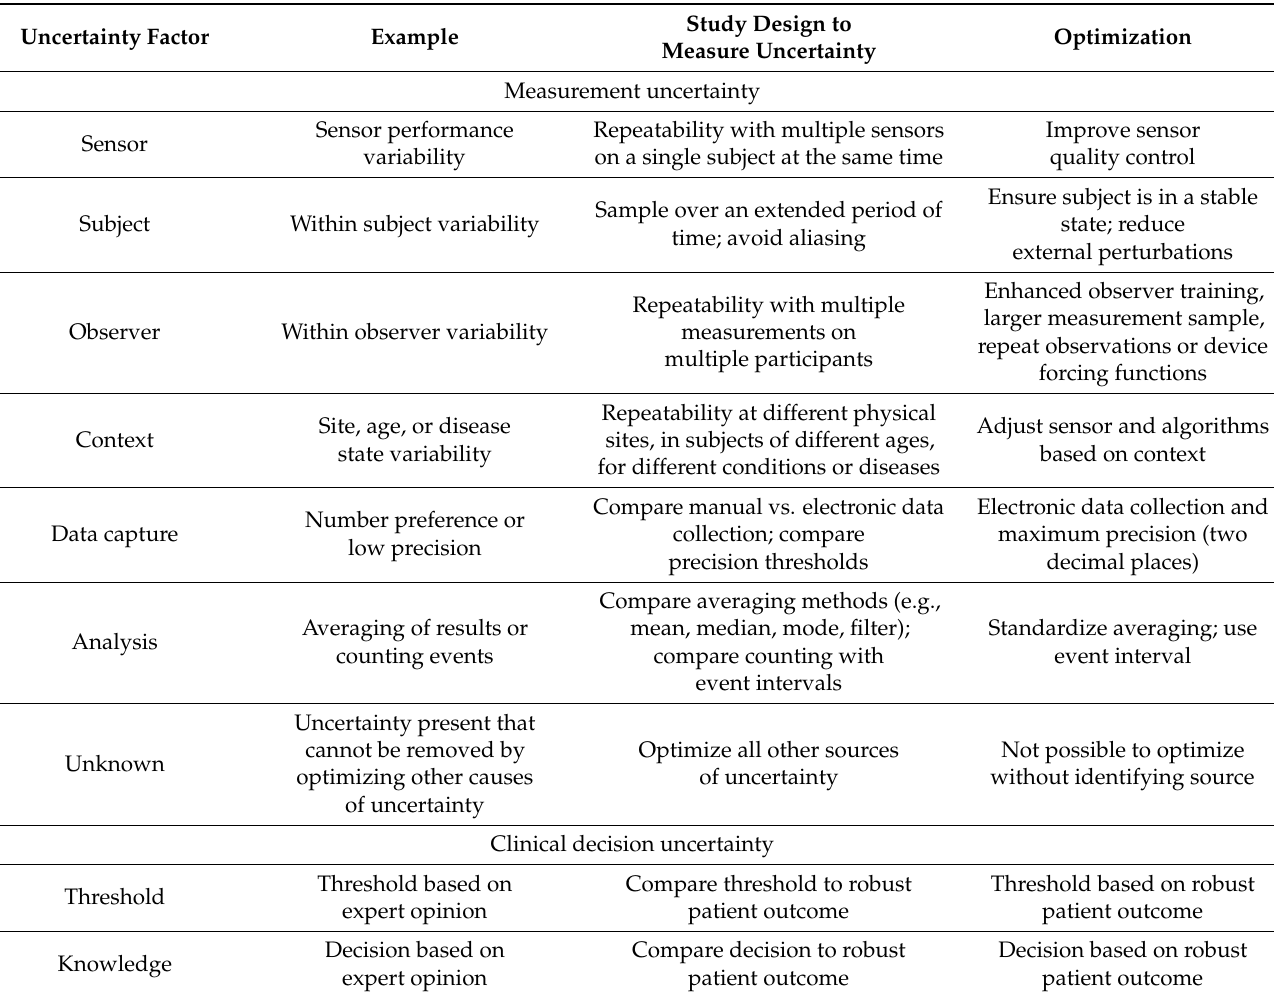
Table 1. Measurement uncertainty